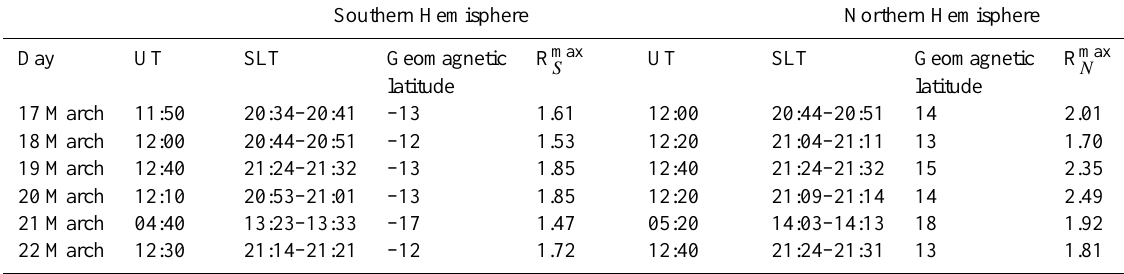
Table 2. The maximum values of the crest-to-trough ratios, R max latitude at 201.45 ◦ geomagnetic longitude. Limits of variation of SLT are determined by SLT of the crest and SLT of the trough.